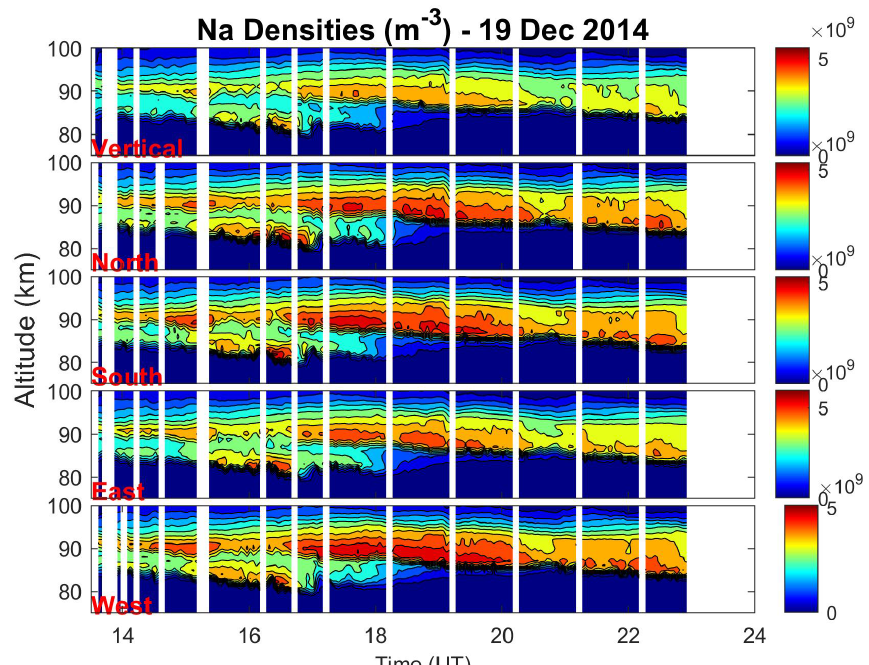
Figure 1. The sodium density measurements from five beam lidar showing formation of a sodium density peak below 85km (intense from 15:00 to 17:00UT). The white regions indicate data gaps.